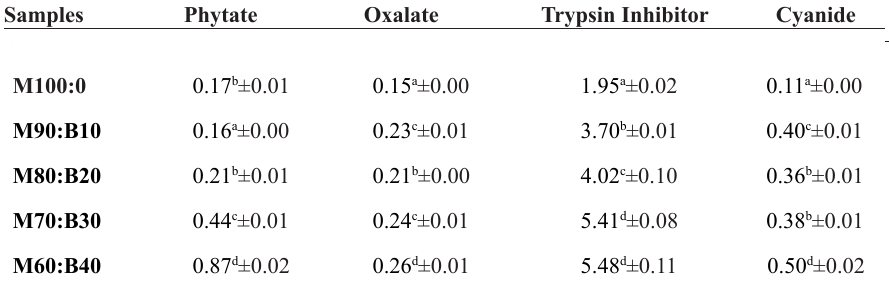
* Values are means ± standard deviations of three replicates of samples. *Means within the same column with different superscripts are significantly different